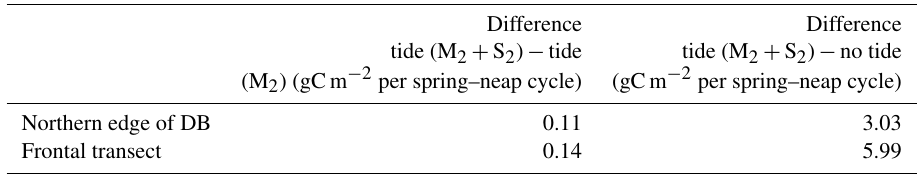
Table A1. NPP contributed by tidal forcing in the transect where Richardson et al. conducted their observation (northern edge of DB) and in the transect where the most pronounced front is located in our simulation (frontal